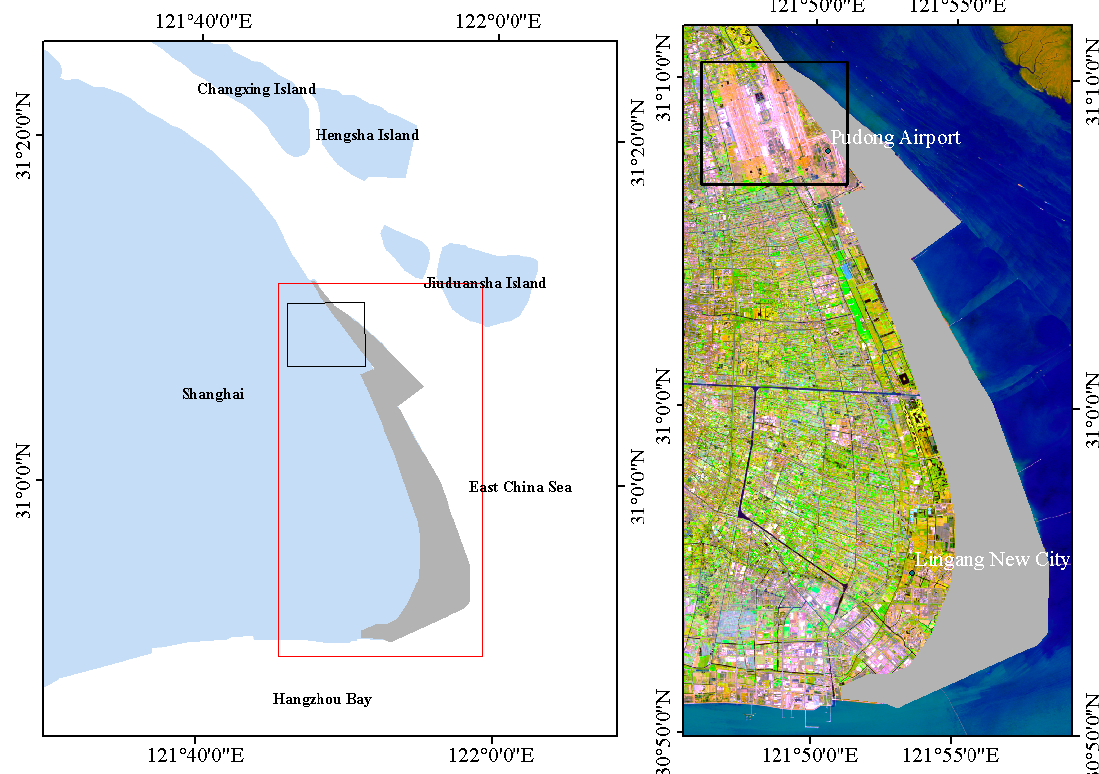
Figure 1. The left image is the location of the study area. The red rectangle is the study area, and the black rectangle is Pudong International Airport. The gray polygon is the area reclaimed from 2002 to the present. The right image is the map of the study area. The background image is a Sentinel2 false color image (the acquisition sate was 28 February 2017; the red channel is the 11th band; the green channel is the 8th band; the blue channel is the 2nd band; the spatial resolution is 10 m × 10 m). In this paper, 32 Sentinel-1A (S1A) images from 20,150,708 to 20,170,826 (C band, orbital